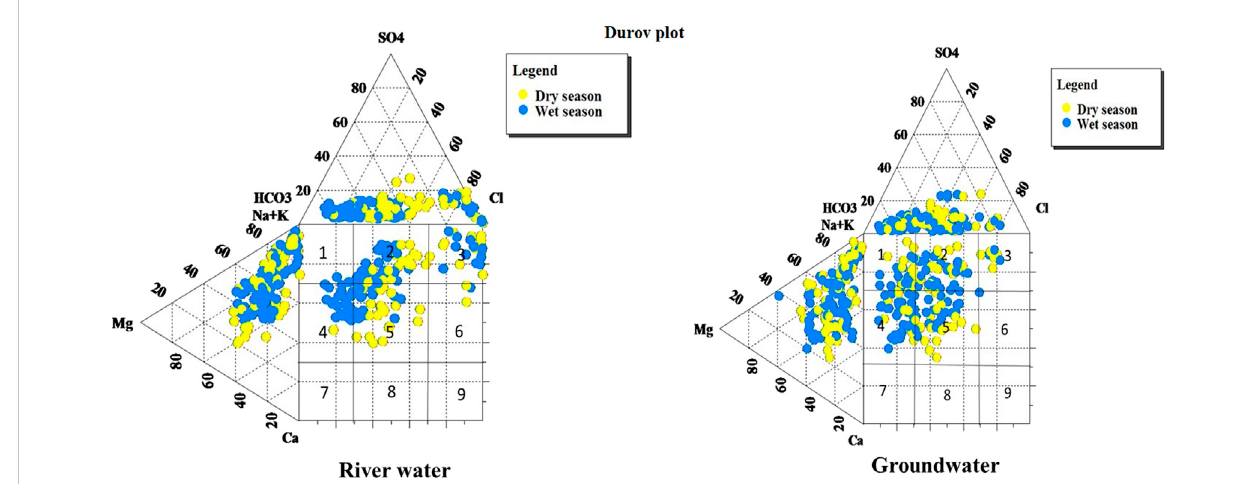
FIGURE 9 Classi fi cation of water based on the Durov diagram (Lloyd and Heathcote, 1985).